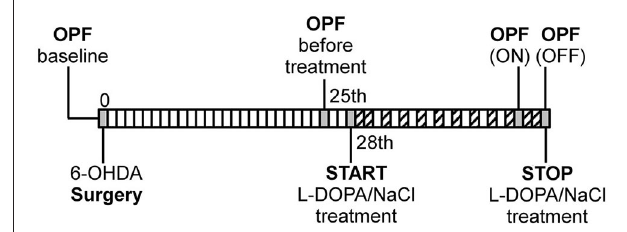
FIGURE 1 | Schematic illustration of experimental design . OPF: open field test, ( : AIM scoring). The first OPF test was performed before surgery as individual baseline measure for each